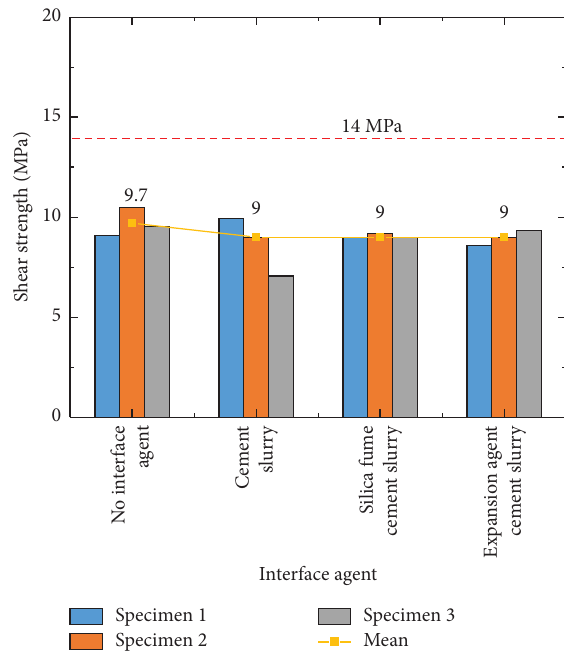
Figure 9: Interfacial bond shear strength with diferent interfacial